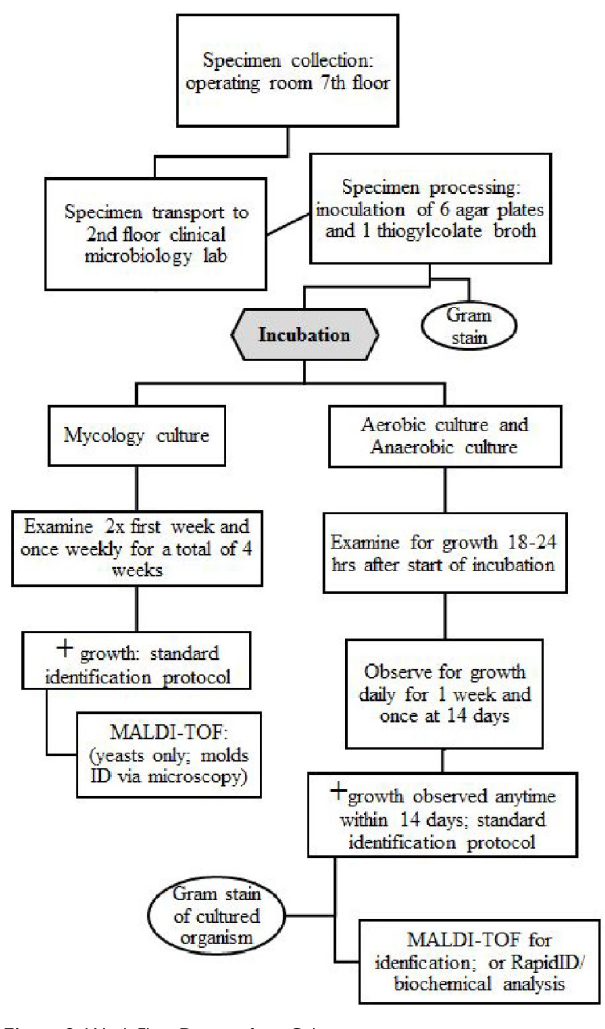
Figure 2. Work Flow Diagram for a Culture